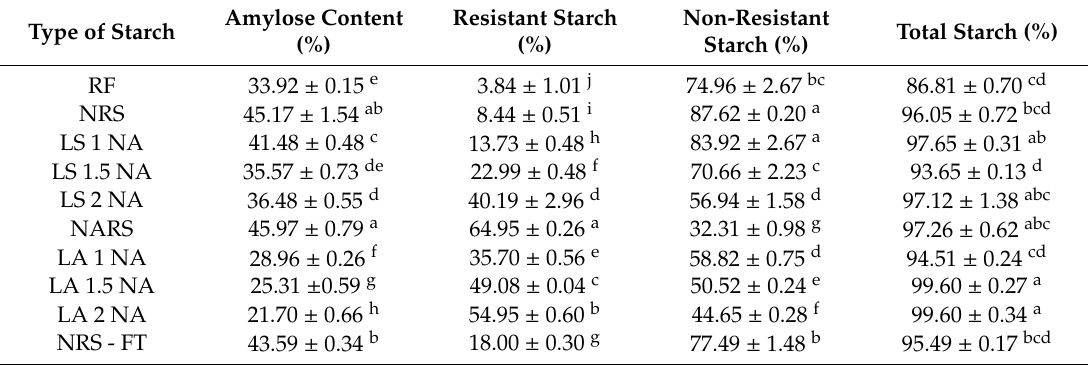
Table 1. Chemical composition of the Pathumthani 80 (RD 31) rice flour, native starch, and modified